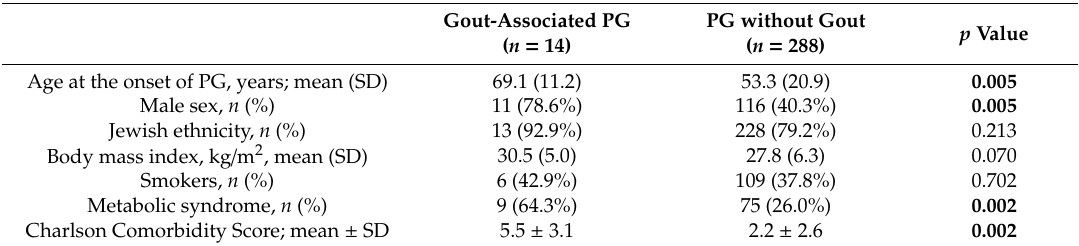
Gout-Associated PG PG without Gout p Value ( n = 14) ( n = 288)